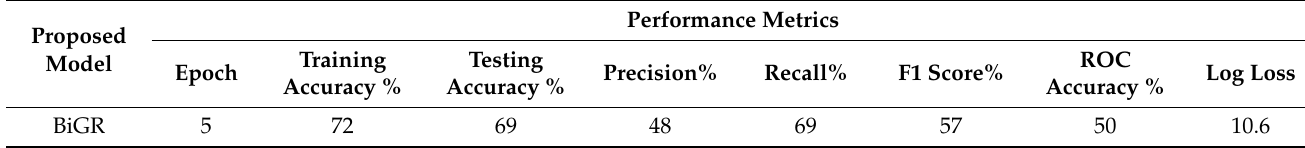
Table 8. The proposed BiGR model results in evaluations without hyperparameter tuning.